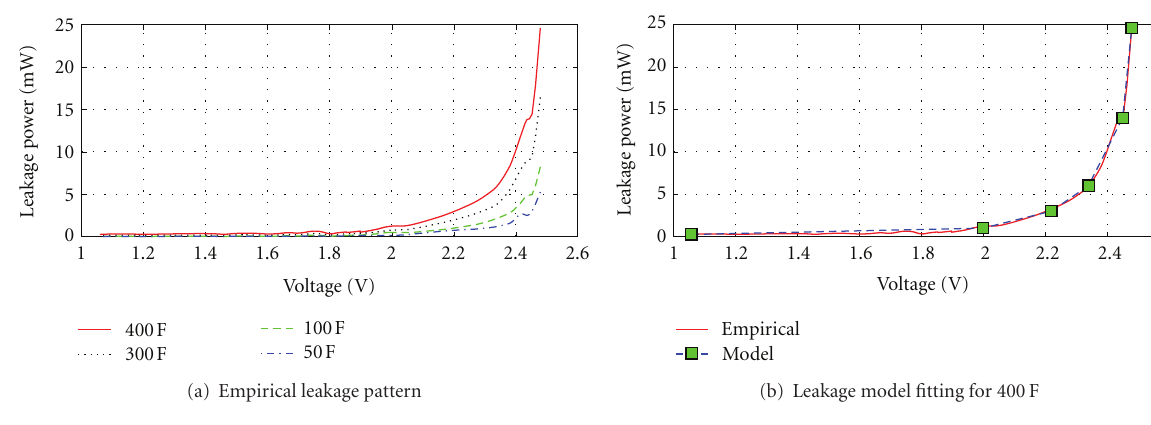
Figure 5: Leakage